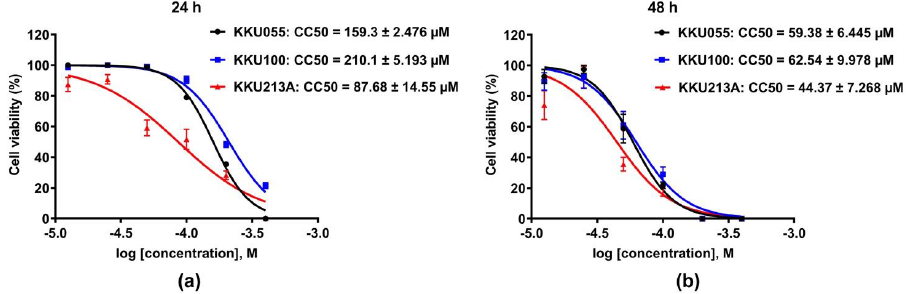
Figure 2. Cytotoxic effect of genistein on CCA cell lines. The percentage of cell viability of KKU055, KKU100, and KKU213A cells after genistein treatment at the concentrations varied from 0–400 µ M were determined at 24 ( a ) and 48 ( b ) hours. The percentage of cell viability at the log of molar concentration was used to calculate CC50 value by using non-linear regression fitted with log inhibitor vs. normalized response (variable slope) of GraphPad Prism software, version 7.0a.